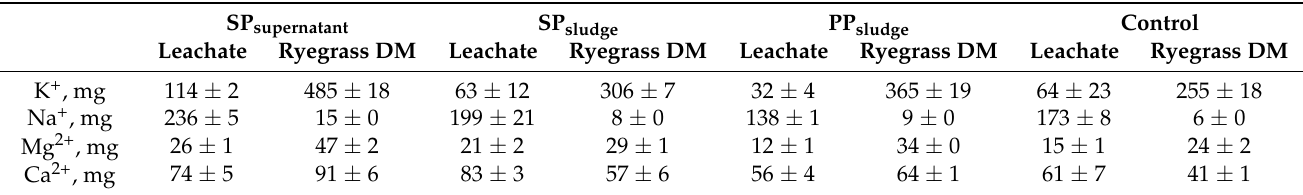
Table 6. Dissolved cations in the leachate and ryegrass